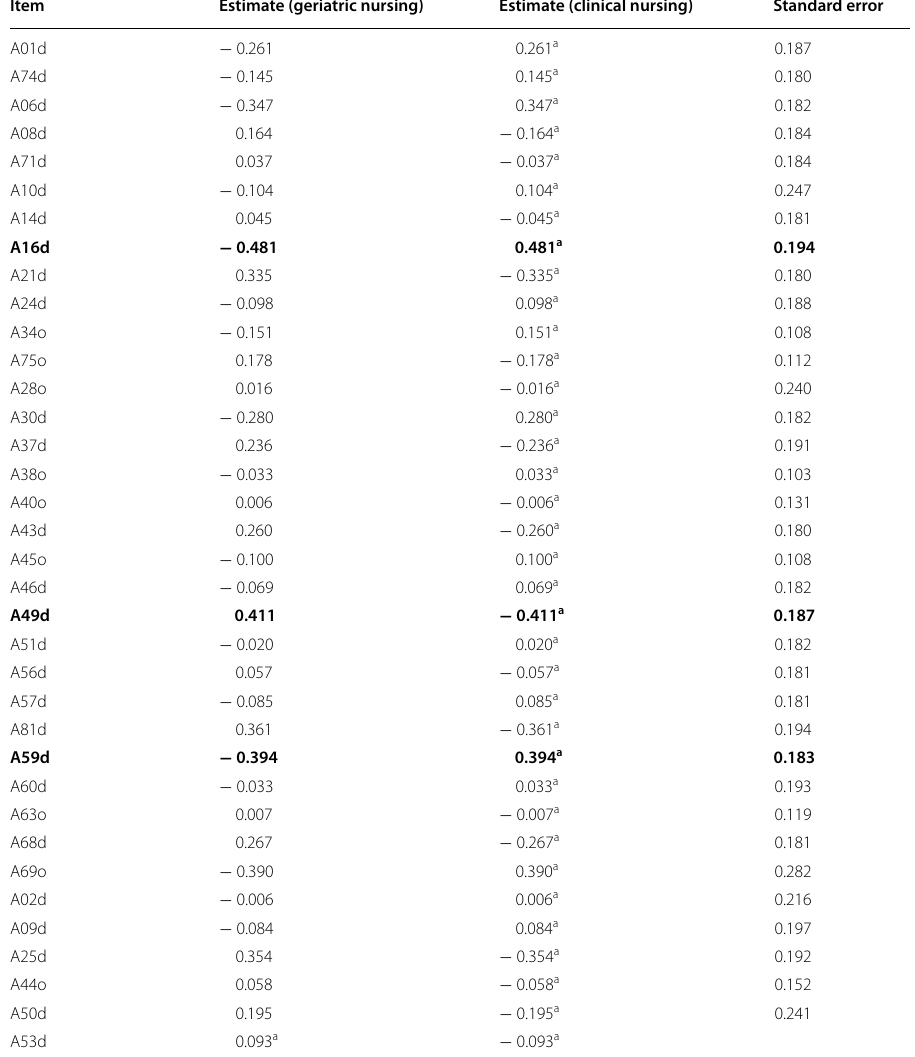
Table 15 DIF item analysis to identify subgroup invariance between specializations at the item level for measurement in the second year